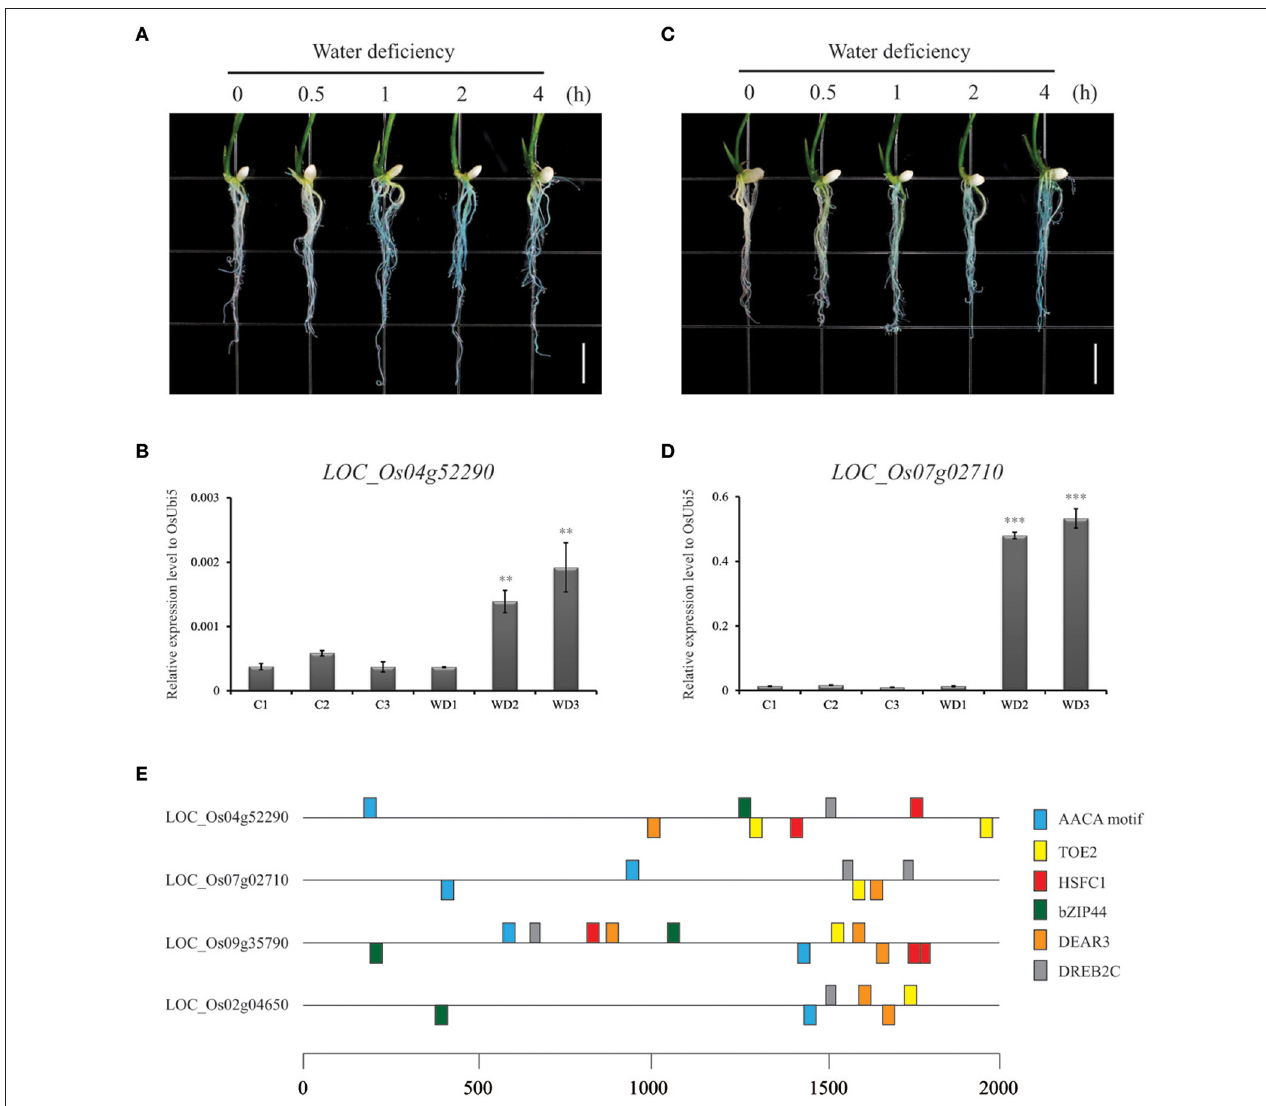
FIGURE 4 | Confirmation of water deficiency-inducible gene expression patterns in rice roots using GUS reporter system and qRT-PCR. To identify in planta expression of selected candidates, we germinated seeds for 2 promoter trap lines (LOC_Os04g52290/3A-03417 and LOC_Os07g02710/3A-13738) in Murashige and Skoog (MS) medium for 7 d and air-dried plantlets for 0.0, 0.5, 1.0, 2.0, or 4.0 h. Whole seedlings were then incubated for 1 h in GUS -staining solution, respectively (A,C) . Expression of two genes was significantly up-regulated by WD, based on qRT-PCR (B,D) . C1, C2, and C3, untreated control (roots from well-watered pots) corresponding to plants under 1d of water deficiency (WD1), 2d of stress (WD2), and 3d of stress (WD3). ** P < 0.01; *** P < 0.001. Identification of 6 conserved CREs of water deficiency-inducible genes (E) . MEME tool was used to find consensus elements in promoter regions of four genes showing GUS induction under water deficiency. Numerals at bottom indicate positions of nucleotides starting from ATG. Detailed information is presented in Table 1 .